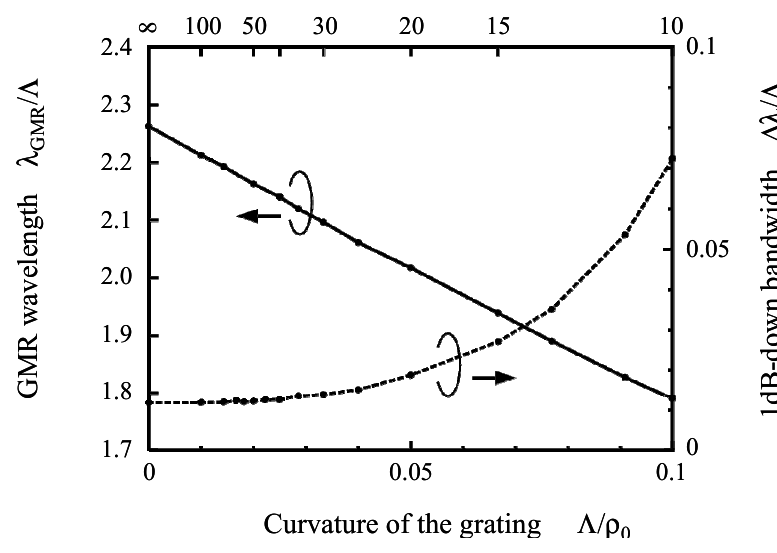
Figure 4. Relationships between the curvature of the grating, GMR wavelength and 1-dB